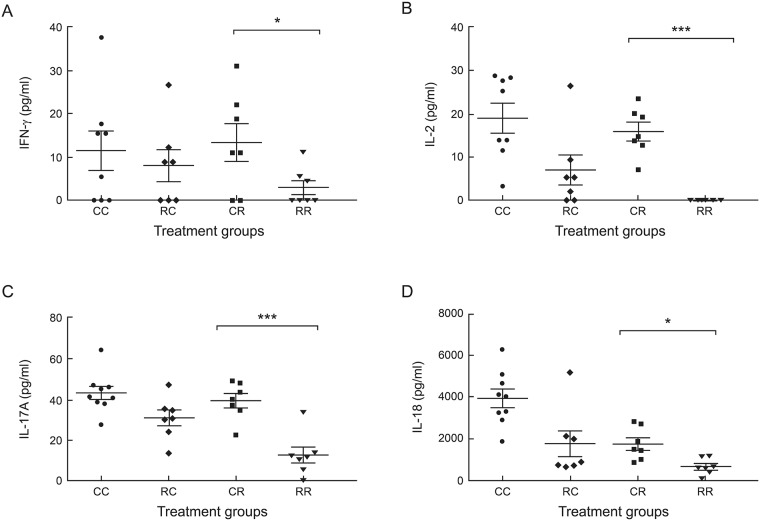
Maternal rrRSV infection alters cytokine expression in offspring with early-life rrRSV LRTI.Serum harvested from 15-day old rat pups at the peak of rrRSV LRTI was analyzed using multiplex cytokine/chemokine ELISA. Data show that maternal rrRSV infection (RR) significantly reduces: (A) IFN-γ, (B) IL-2, (C) IL-17A, and (D) IL-18 in offspring with primary early-life rrRSV LRTI compared to RSV-naïve controls (CR). Data for 3 experiments were combined and expressed as the mean ± SEM of ≥7 rats per group. Two-tailed student’s t test: *P<0.05, ***P<0.001 compared to the RR group.